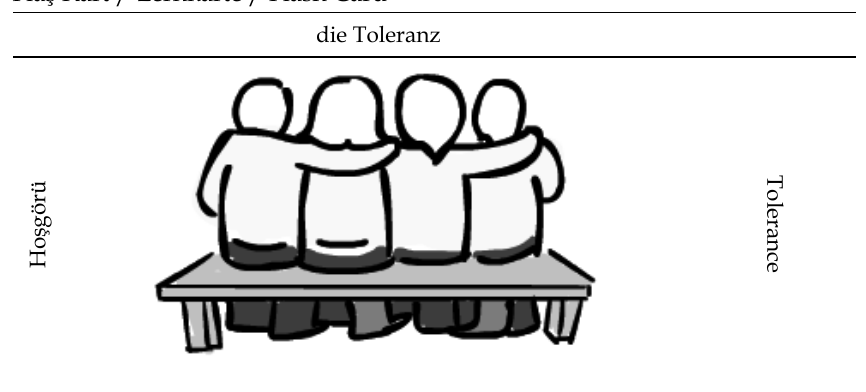
Table 1. Flash card for “tolerance” The keyword and the 24 words in the